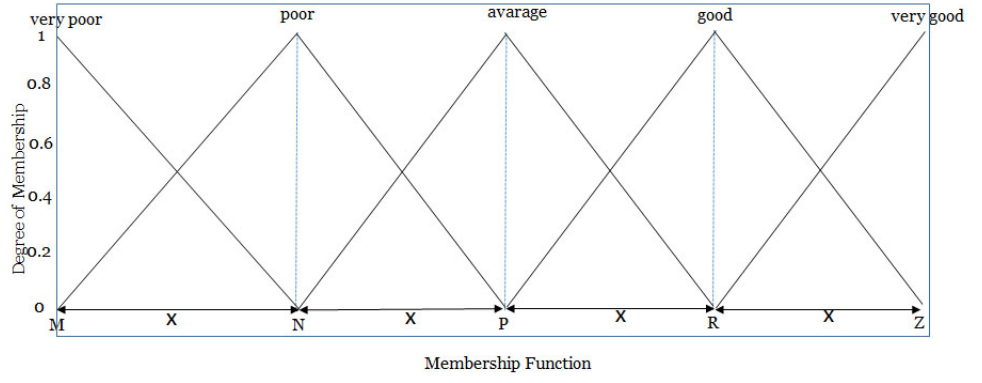
Figure 4. Classical fuzzy membership function.